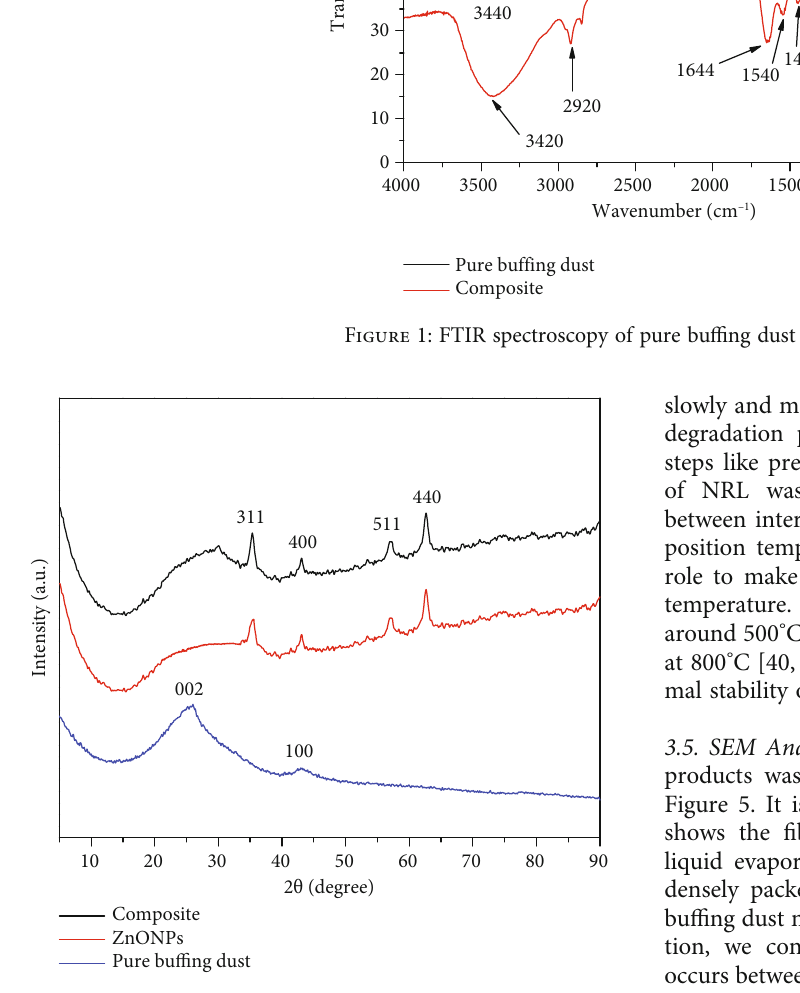
Figure 2: XRD analysis of pure bu ffi ng dust and